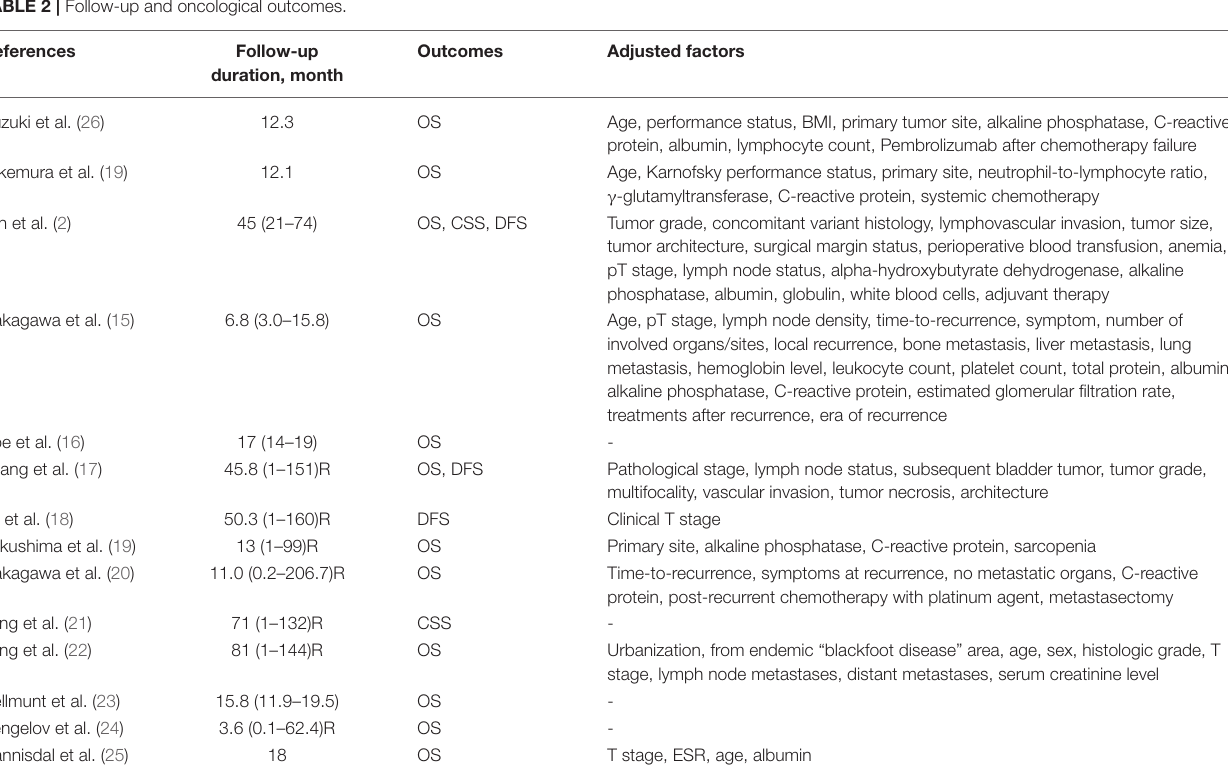
TABLE 2 | Follow-up and oncological